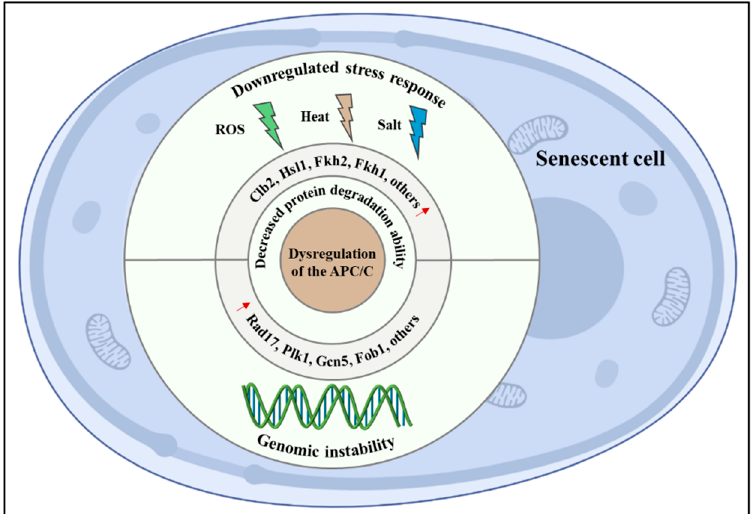
Figure 1. Mechanisms of the anaphase-promoting complex/cyclosome (APC/C) in regulating lifespan. Dysregulation of APC/C can trigger the abnormal accumulation of its substrates, thus, leading to genomic instability and downregulated stress response. Some lifespan determinants, such as Fob1 and Fkh1, are both identified as a bona fide APC/C substrate, indicating that APC/C promotes longevity at least partly owing to the degradation of them.